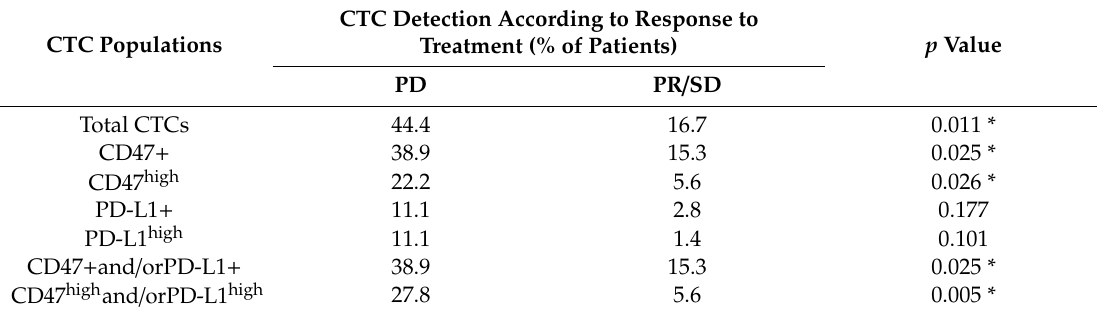
Table 3. Incidence of CD47 and PD-L1 expression on CTCs of patients with metastatic BC ( n = 90) according to best response at first evaluation of